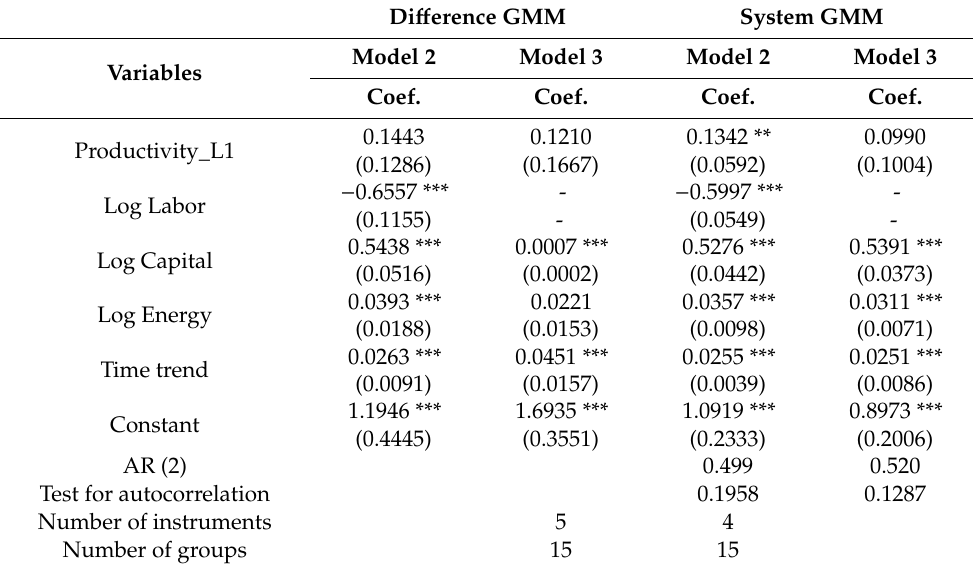
Table 6. Dynamic panel estimation results for Models 2 and